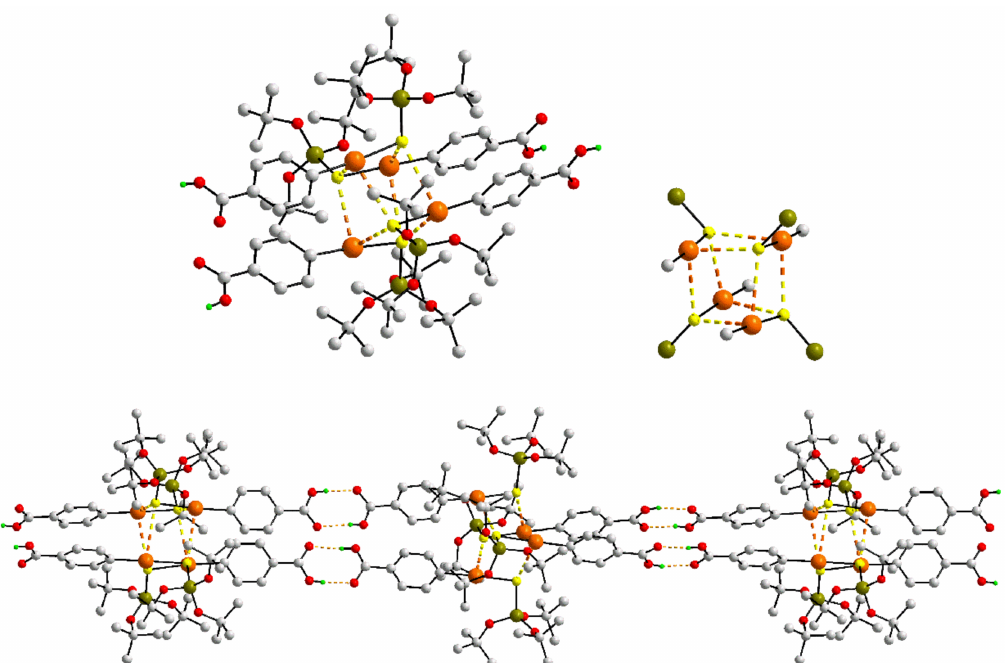
Figure 10. Supramolecular associations in 36 : upper view—four-molecule aggregates featuring Hg · · · S contacts cooperating with an additional four Hg · · · S contacts beyond the van der Waals radii (right-hand image: simplified view); lower view—supramolecular chain whereby alternating four-molecule aggregates are linked by carboxylate-O–H · · · O(carbonyl) hydrogen bonding.